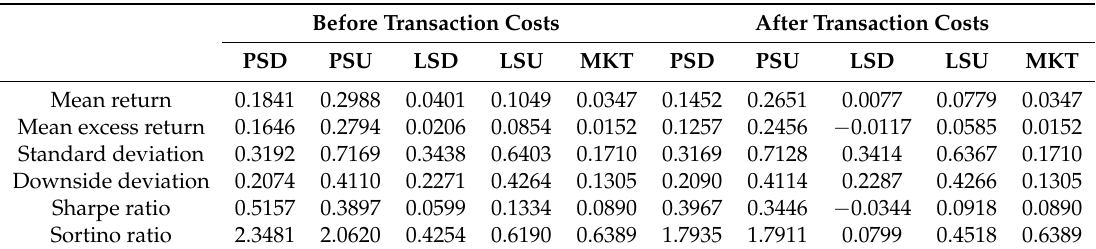
Table 4. Annualized risk-return measures for PSD, PSU, LSD, and LSU from January 2000 until December